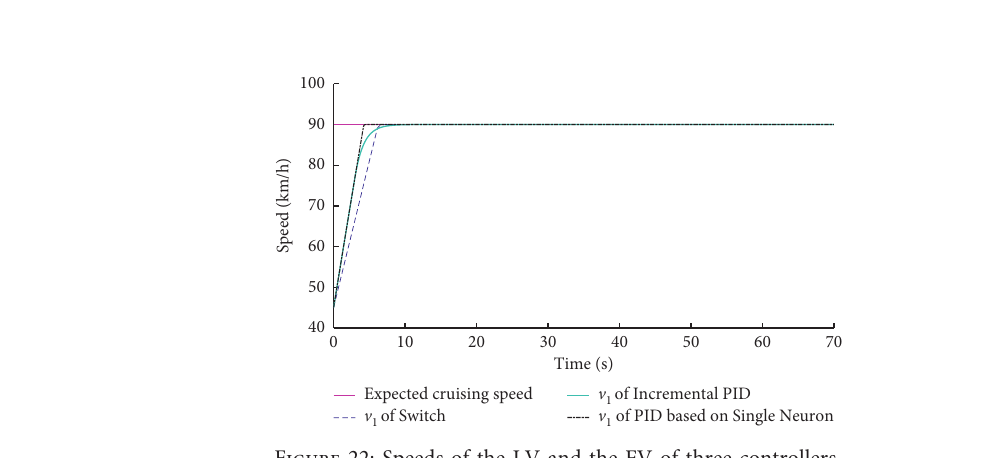
Figure 22: Speeds of the LV and the FV of three controllers.